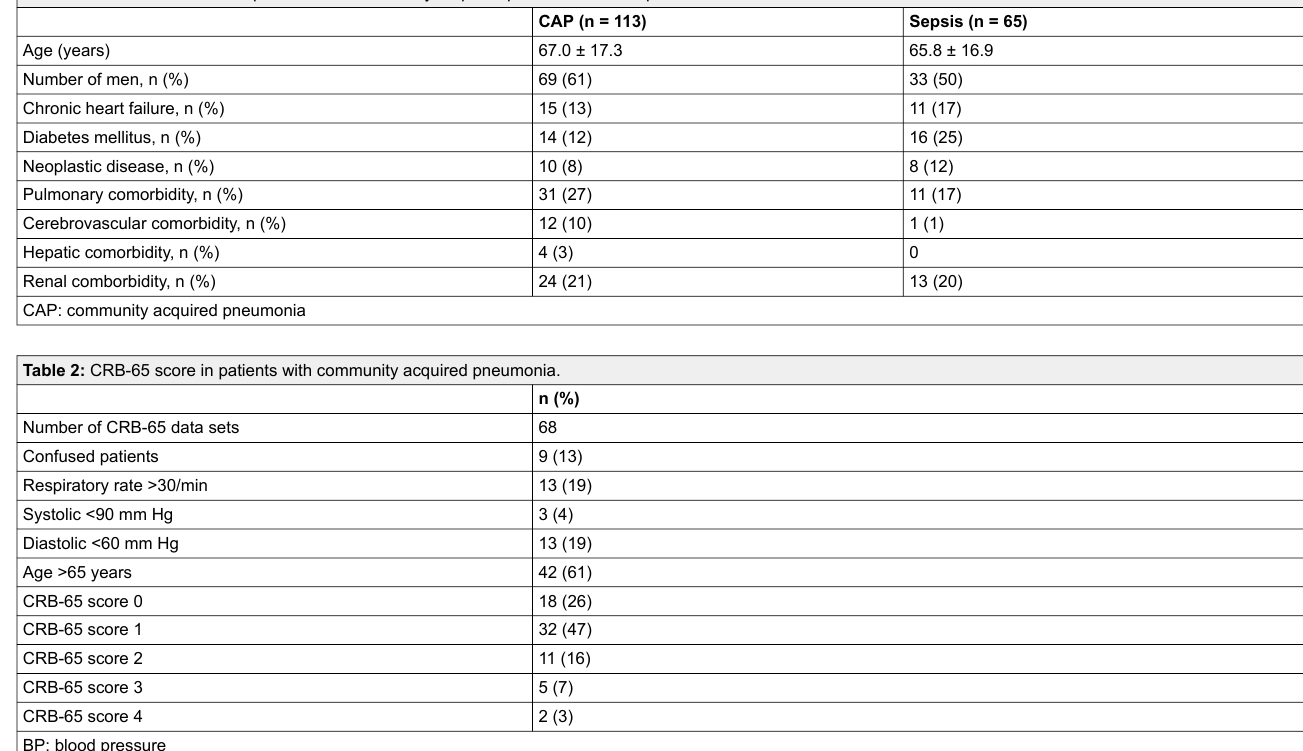
Table 1: Characteristics of the patients with community acquired pneumonia and sepsis.